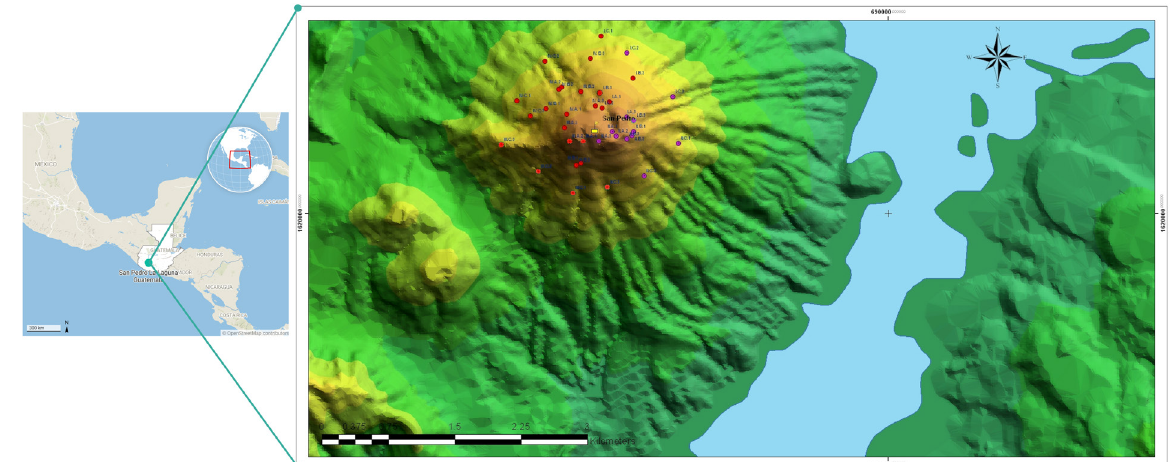
Figure 1. Location and georeferencing of the sampling carried out in the San Pedro volcano (San Pedro La Laguna, Guatemala). In red the samplings corresponding to the association Saurauio oreophilae-Alnetum acuminatae ass. nova. In violet the samples of association Adianto andicolae-Quercetum peduncularis ass.